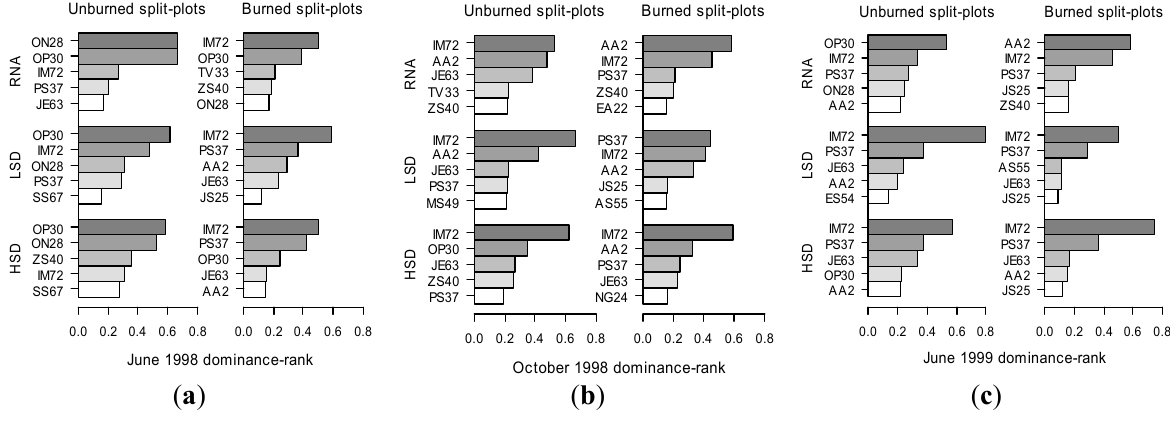
Figure 7. ( a–c ) Dominance rank coefficients ( D (and immature oribatids in some instances) in assemblages from each forest structural condition during each sample interval. Refer to Table 1 for an explanation of the species